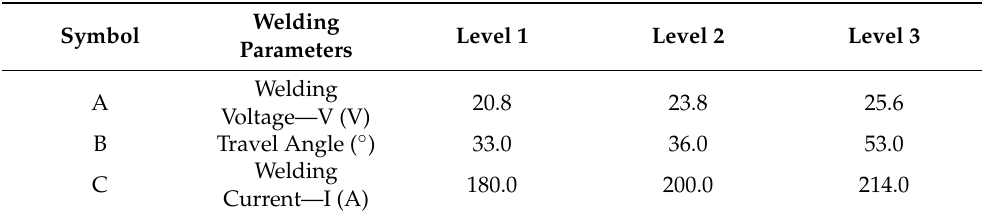
Table 1. Welding process parameters and their levels.